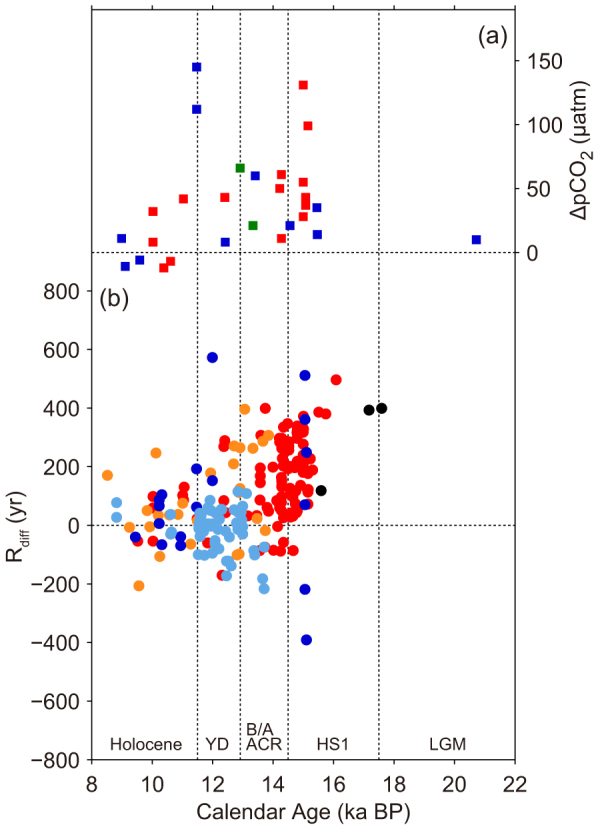
Differences between modern and deglacial pCO2 and R (ΔpCO2 and Rdiff).The last deglaciation is characterized by larger and more variable pCO2 and R values. (a) Atmosphere-ocean ΔpCO2 based on Tahiti and Marquesas corals and Antarctic ice core1. Figure legend is same as Fig. 3. (b) Rdiff around the equatorial Pacific Ocean calculated from fossil corals (red: offshore Tahiti; orange: reef crest of Tahiti barrier reef58, blue: Marquesas26; light blue: Kiritimati59; black: Mururoa58). Horizontal dashed lines represent ΔpCO2 = 0 and Rdiff = 0.